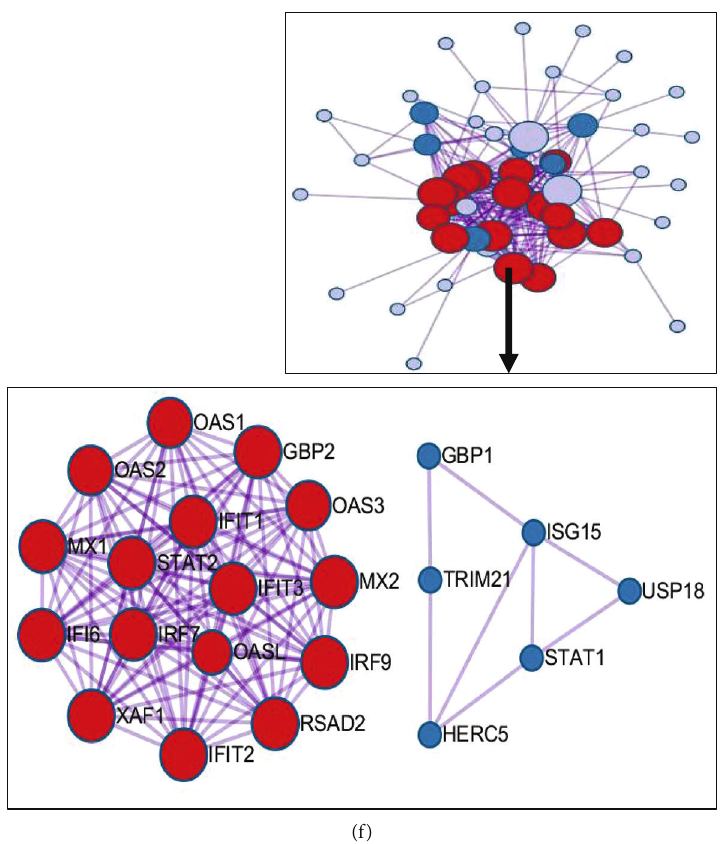
Figure 3: Dataset selection and DEG enrichment analysis. (a) The volcano map of the di ff erentially expressed genes of IFN- α -2b acting on fi broblasts in the dataset GSE38652. (b) Based on the STRING database, the PPI interaction network diagram showing signi fi cant DEGs with an absolute value of logFc ≥ 1 . (c – f) Enrichment analysis results based on Metascape. (c) GO enrichment analysis results; (d) KEGG pathway enrichment analysis; (e) TRRUST transcriptional regulatory network analysis results; (f) di ff erential gene interaction relationship PPI network diagram and hub